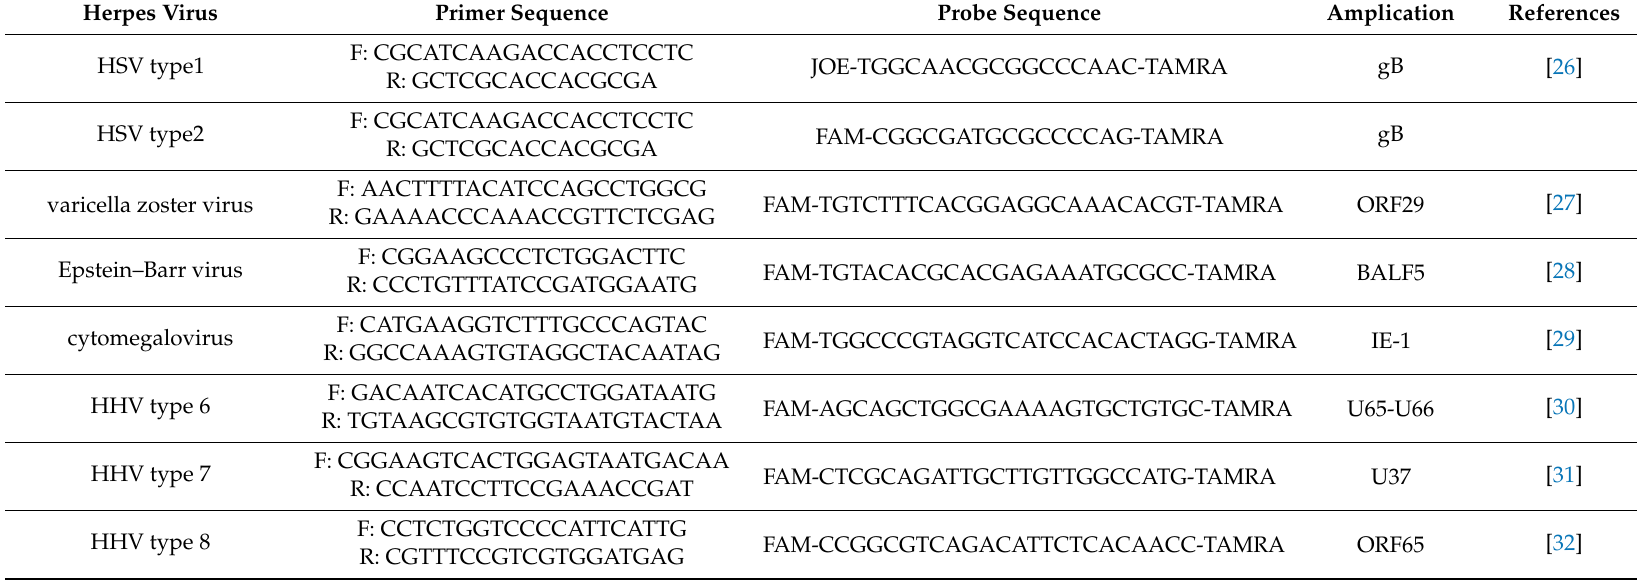
Table 3. Sequences of primers and probes in human herpes viruses using quantitative real-time